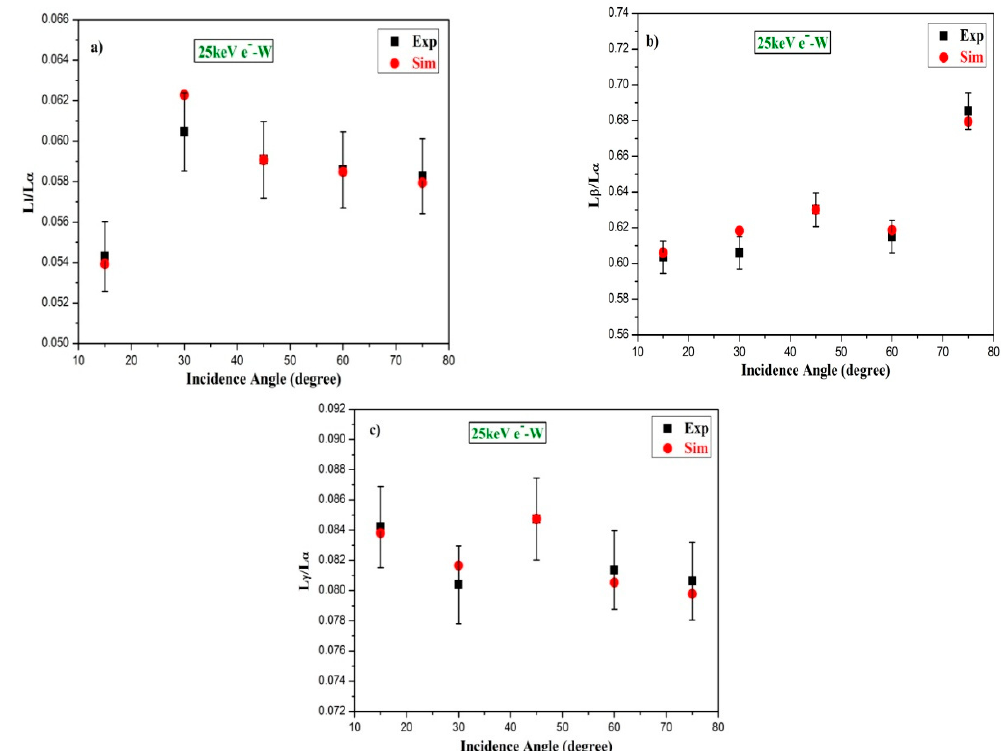
Figure 4. Comparison of variation of the measured X-ray line intensity ratios of ( a ) L l / L α , ( b ) L β / L α and ( c ) L γ / L α with that of the calculations from the PENELOPE simulation code for collisions of 25 keV electrons with a thick W target as a function of incidence angle. The black filled squares represent experimental data while red filled circles are data from simulation.